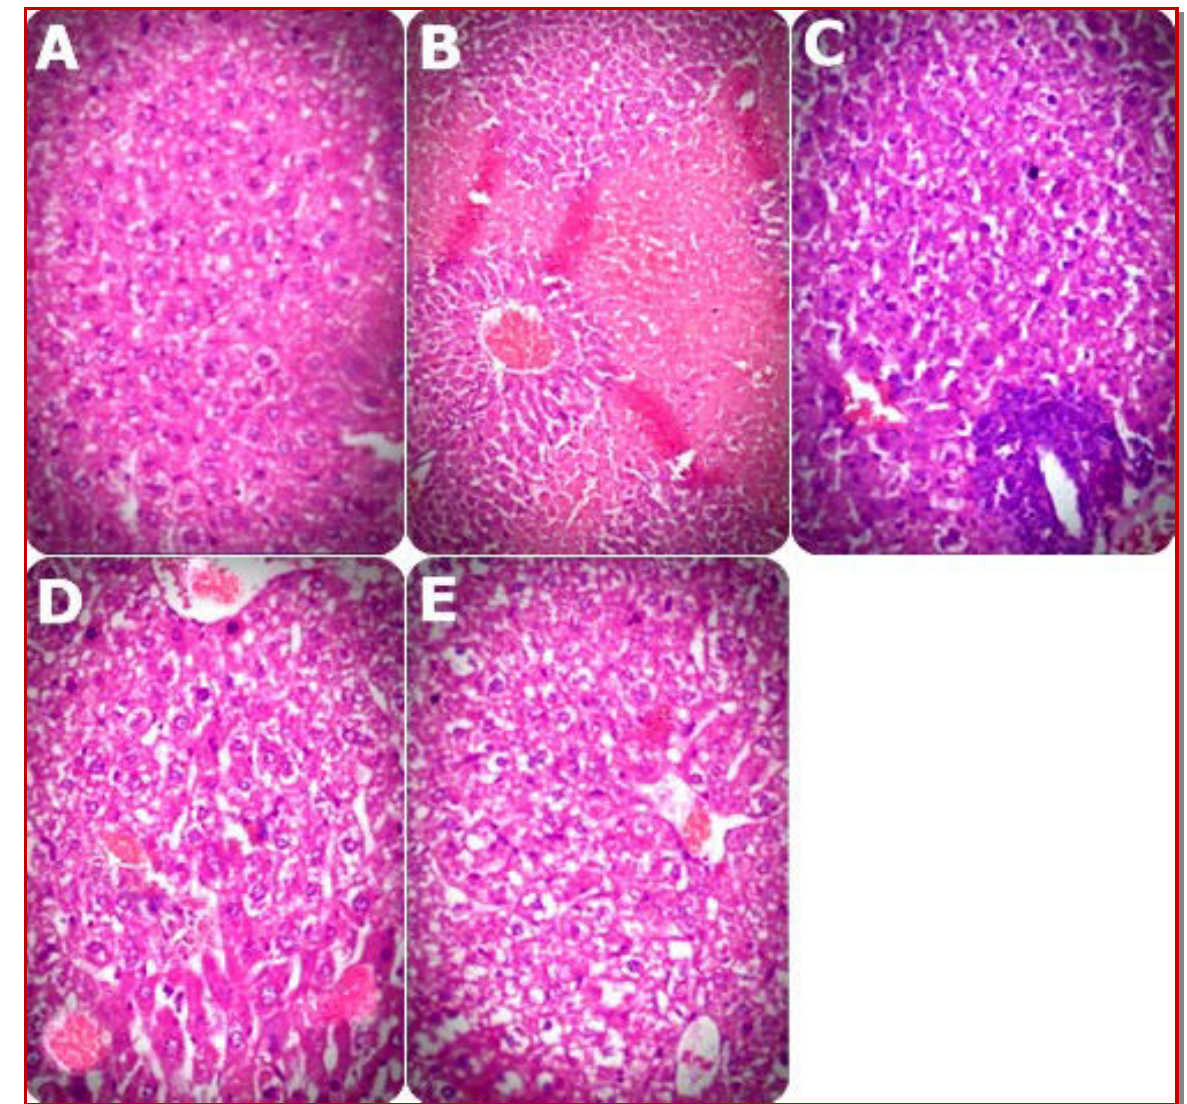
Figure 2: Histopathological pictures of (A) Normal hepatocytes (B) Paracetamol treated group, marked inflammation, necrosis, sinusoidal constrictions and ballooning (C) Silymarin treated group, improvement in necrosis, inflammation, ballooning and mod- erate dilatation of sinusoids (D) Extract 250 mg/kg treated group, mild inflammation ballooning and moderate sinusoidal dilata- tion (E) Extract 500 mg/kg treated group, moderated inflammation, mild ballooning, mild necrosis and moderate sinusoidal dila-